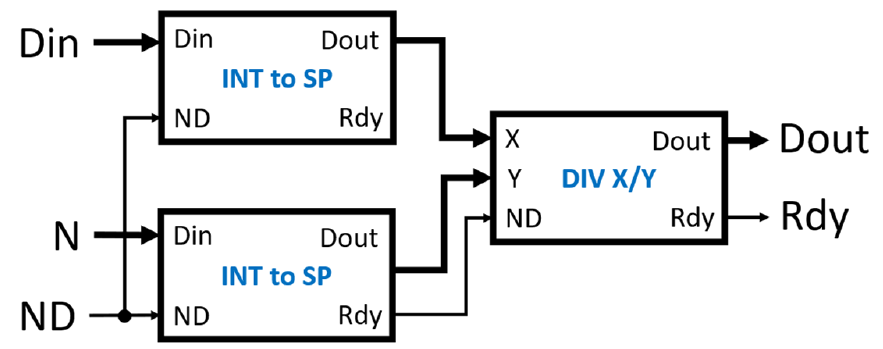
Figure 7. The diagram of the normalizer module. The INT to SP modules convert the integer inputs Din and N to single-precision floating-point numbers. The Rdy from either INT to SP module is used as the ND input of the division module (DIV X/Y) because both Rdy signals are already synchronized. As the combiner modules essentially double the input data in the multi-tau correlator, it is necessary to scale down the output data based on the linear correlator stage where the data come from. The output data need to be scaled down by a factor of 4 N , where N is the number of combiner stages that the input data went through to generate that output. In our multi-tau correlator, there is no scaling necessary for the first 16 correlation values. For the next eight correlation values, the outputs need to be scaled down by a factor of 4. The scale factor will be quadrupled every eight lags thereafter. The scaling module takes advantage of the format of an IEEE 754 single-precision floating-point value, which breaks up the binary of the single-precision floating-point value into three parts: a sign bit, an 8-bit exponent, and a 23-bit fraction. The value represented by these parts is given by the expression ( − 1 ) s × 2 E − 127 × ( 1 × f 1 f 2 . . . f 23 ) where s is the sign, E is the